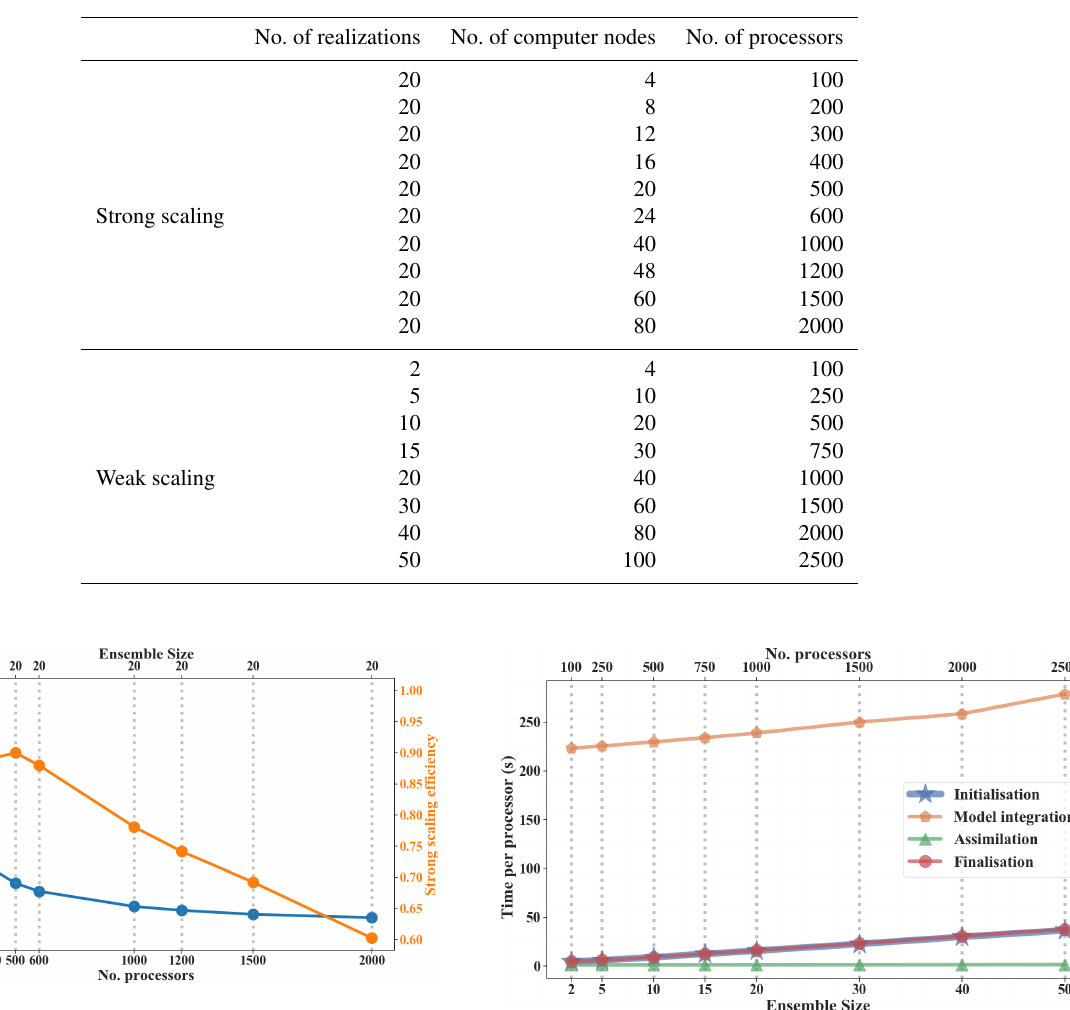
Figure 4. Timing information (blue line) and scaling behavior (or- ange line) for the NAQPMS-PDAF for a strong scaling test. The ensemble size is a constant of 20 and increases the processors from 100 to 2000 with a total of 10 tests.